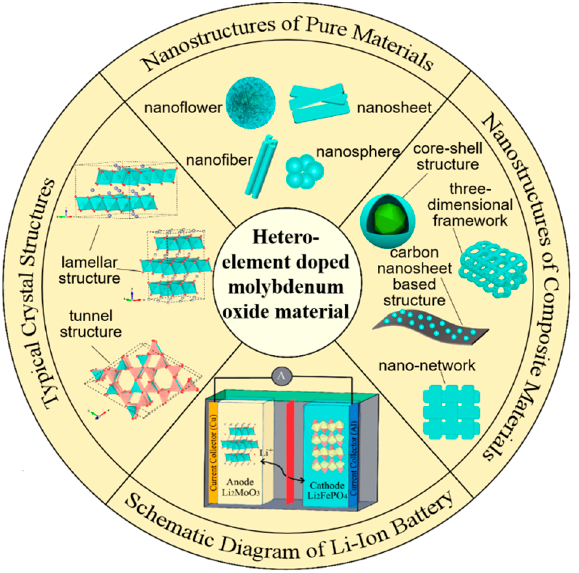
Figure 1. Summarization of some typical crystal structures and nanostructures of hetero-element- doped molybdenum oxide materials, as well as the schematic diagram of their application in energy storage